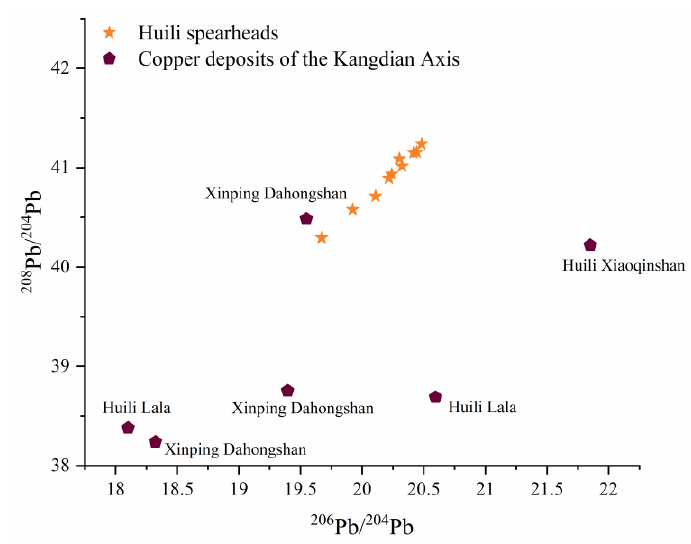
Figure 3. Lead isotope ratios of Huili spearheads and copper deposits of the Kangdian Axis.